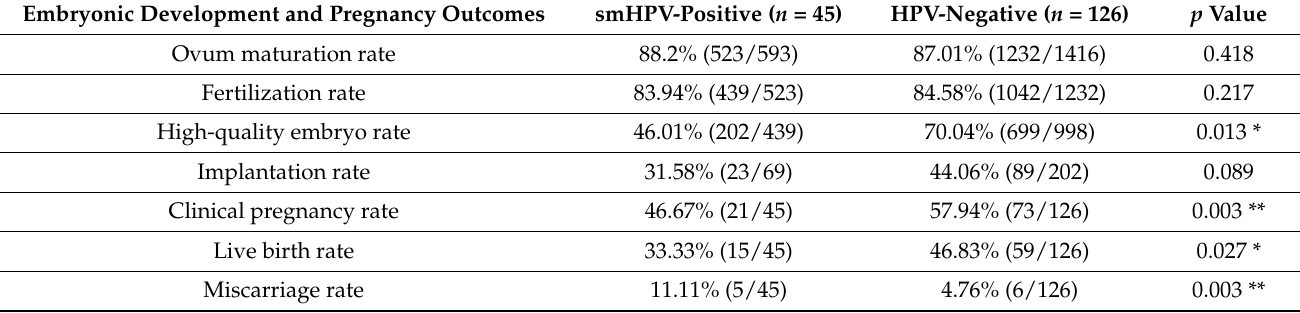
Table 4. Embryonic development and pregnancy outcomes for single-male-factor HPV-positive and HPV-negative groups.